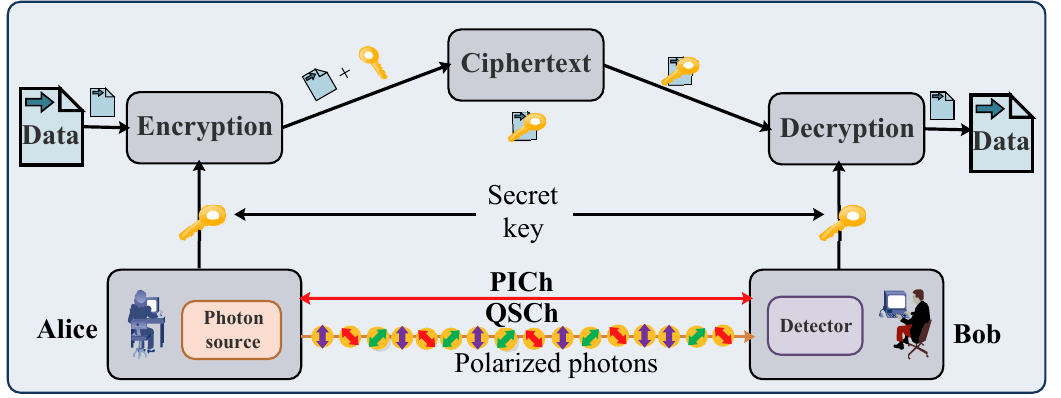
Figure 8. QKD process